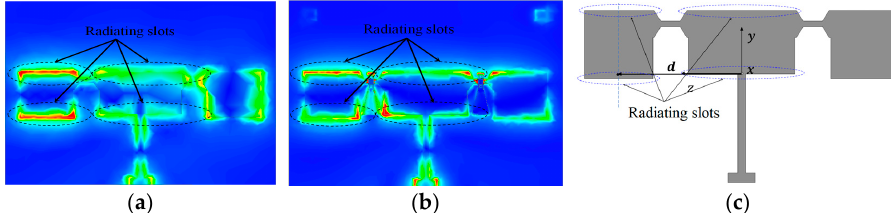
Figure 4. Distribution of surface current density of antenna. ( a ) Left switch in the up state and right in the down state; ( b ) Left switch in the down state and right in the up state. (Note that switches were replaced by conductor patch without loss of generality.)